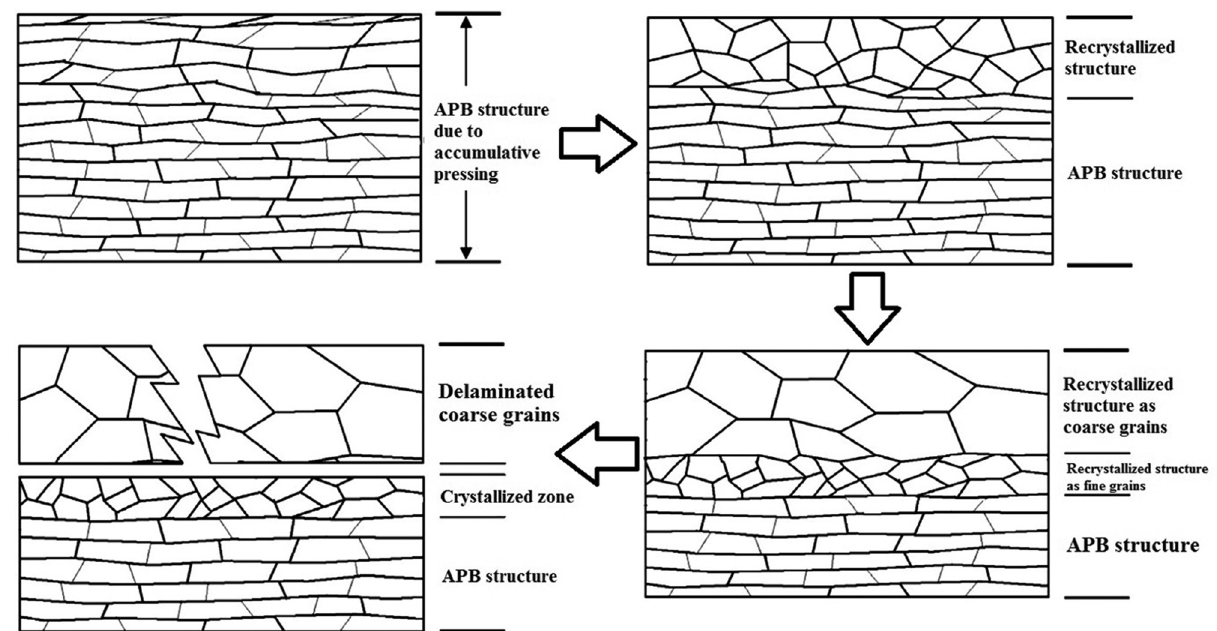
Figure 12: Schematics of the sliding wear of ARB composite samples vs di ff erent steps of deformation and recrystallization